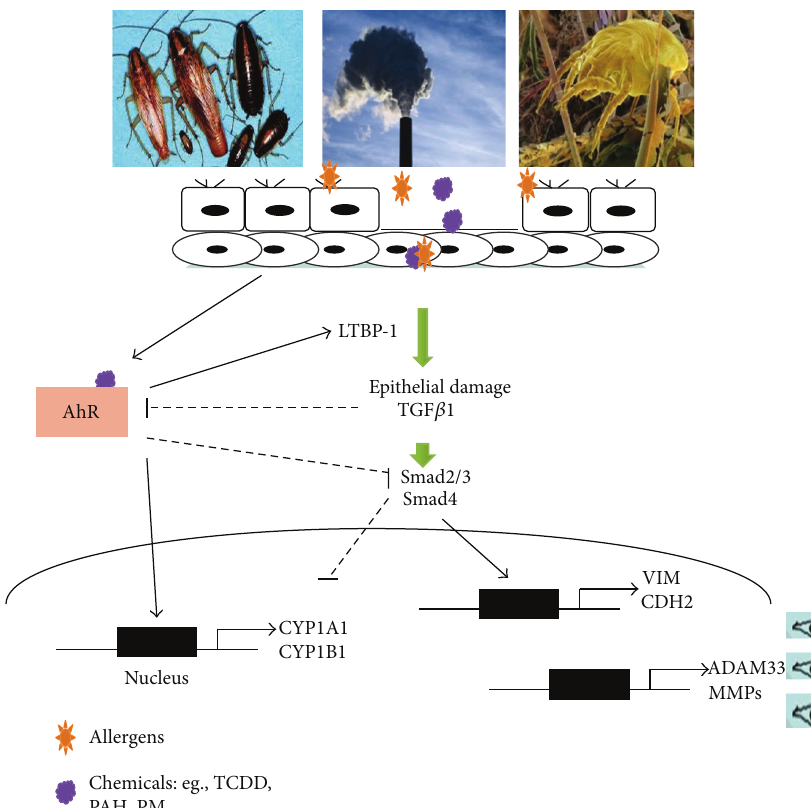
Figure 7: Proposed model of the role of AhR in modulating environmental chemicals and allergens induced activation of TGF 𝛽 1 signaling (modified from an article by Denison and Nagy 2003)